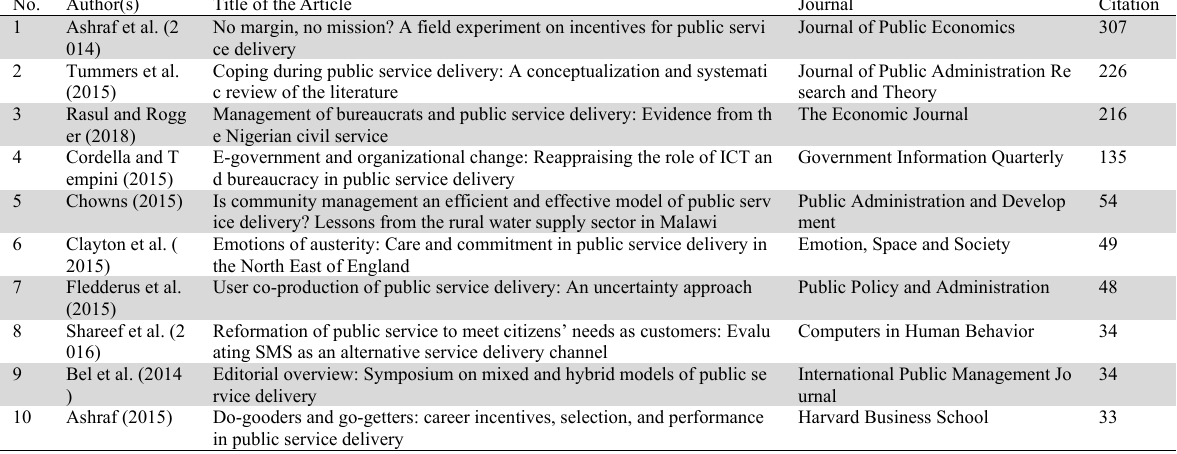
Most recent individual work on the concept of public service delivery over the last five years (between 2014 to 2019) and ac cording to the citation index